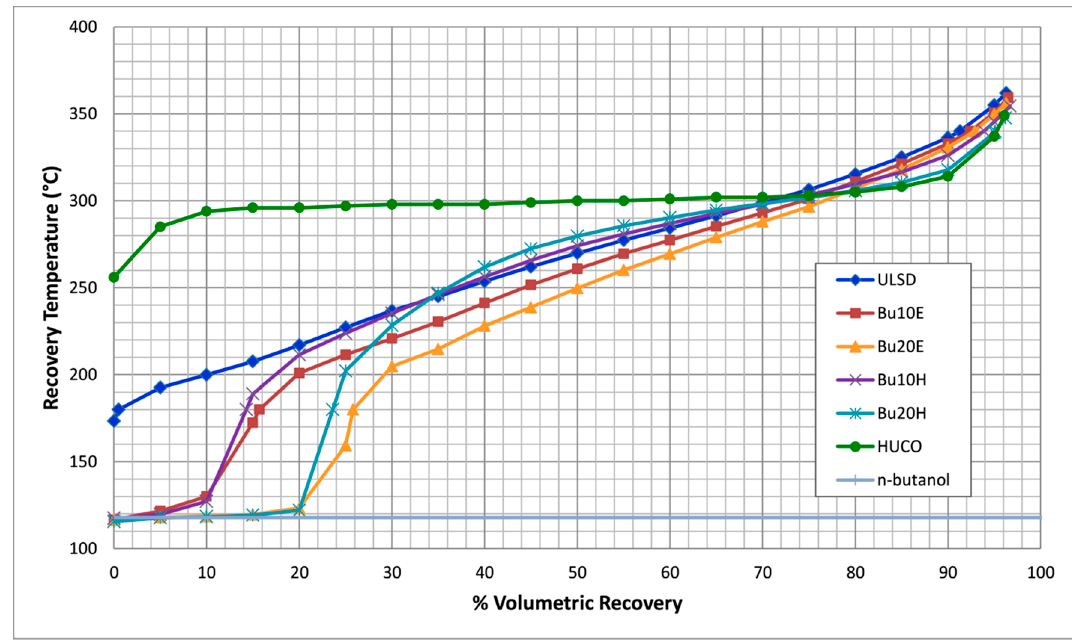
Figure 6. Distillation properties of fuels and blends used.